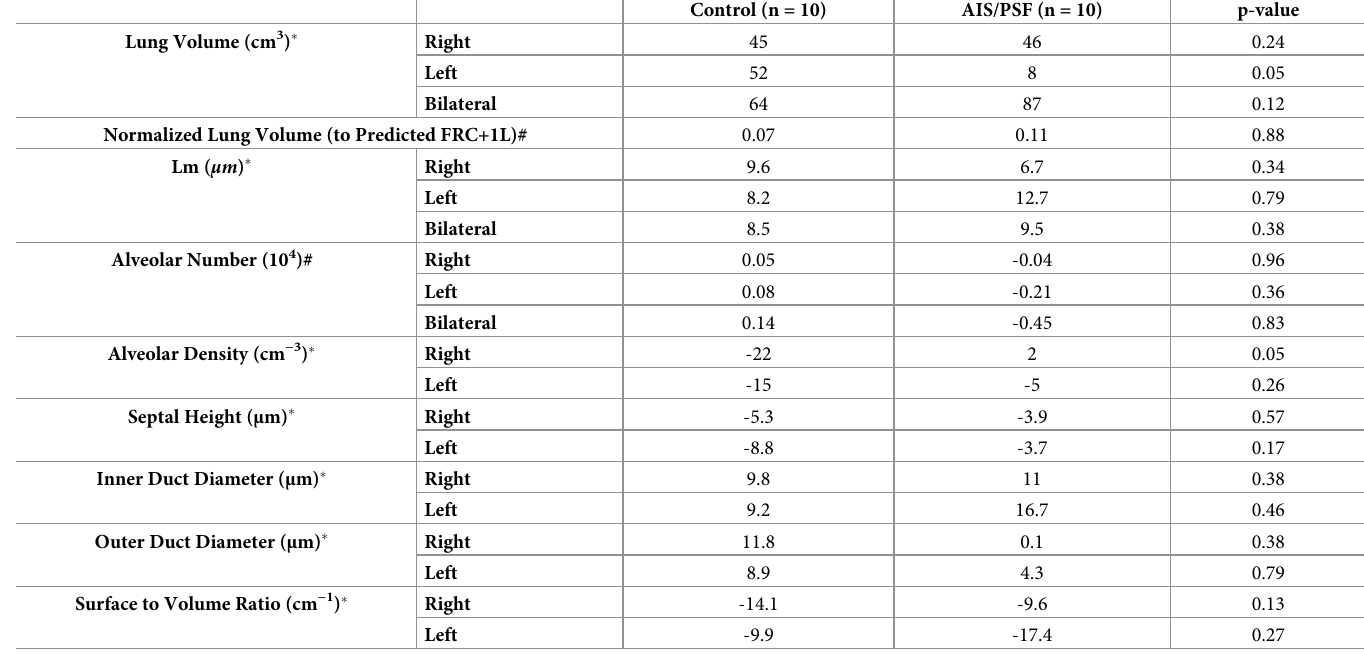
Fig 3. Change in alveolar size at one year. (A) In the left/concave and (B) right/convex lungs of control and AIS subjects, there was the expected increase in alveolar size over time without significant differences between them. Lines connect subjects and the shaded regions indicate standard error for both the first and 1-year HHe images as determined using generalized linear modeling. https://doi.org/10.1371/journal.pone.0240265.g003 the concern with poor age matching. (c) Follow-up time may have been insufficient. The one- year follow-up time was chosen based on normal post-operative clinic scheduling after PSF (the latest routine follow-up in the orthopedics clinic). It is possible that one year was insuffi- cient follow-up to discover structural changes following PSF and to see whether the alveolar Table 4. One year post-PSF